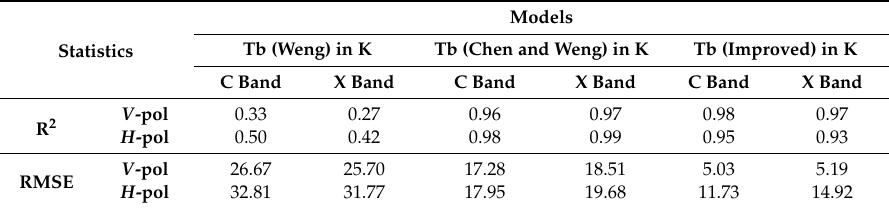
Table 4. Statistics for comparisons between the measurements and the simulations using the Weng, Chen and Weng, and the parameterized soil surface emissivity models ( Tb : brightness temperature in K , V -pol: vertical polarization, H -pol: horizontal polarization).